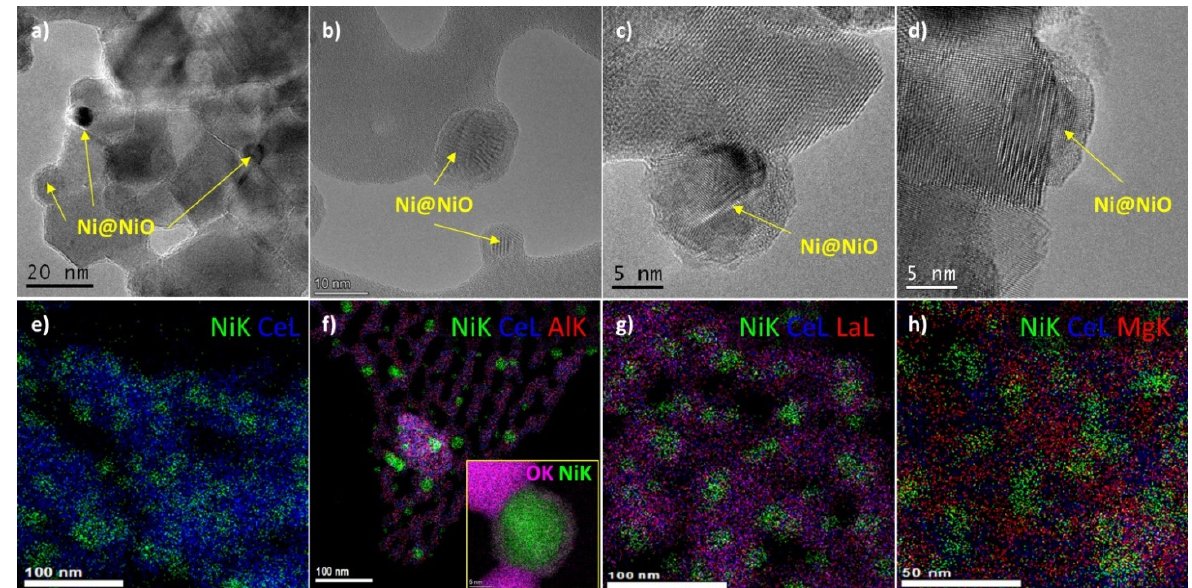
Figure 15. HRTEM pictures ( a – d ) and EDX mapping ( f – h ) of Ce 0.8 Ni 0.2 O y ( a , e ) and (CeM) 0.8 Ni 0.2 O y (M = Al ( b , f )), La ( c , g ), Mg( d , h )) samples. M/Ce molar ratio is equal to 1.